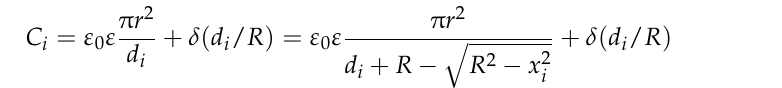
Figure 6. Rotating shaft vibration capacitive type 2 sensors with concentric electrodes: 1.1—potential electrode, 1.2—guard electrode, 1.3—ground, 2—shaft.